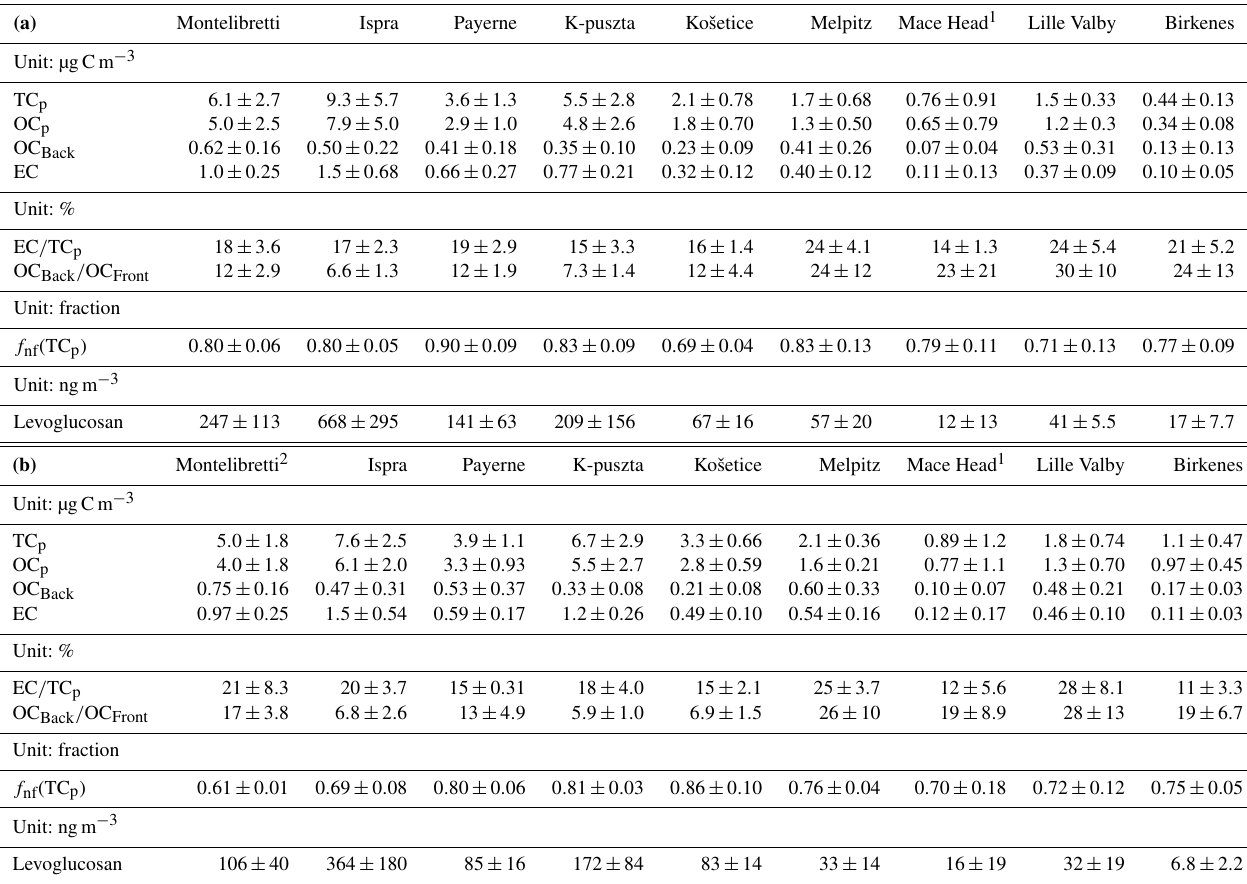
Table 2. (a) Mean ( ± SD; standard deviation) concentrations of carbonaceous sub-fractions and levoglucosan in PM 1 2009. The EC / TC p ratio, the OC Back / OC Front ratio, and non-fossil fractions of TC p ( f nf (TC p )) are also listed. The sites are ordered by latitude from south to north. (b) Mean ( ± SD; standard deviation) concentrations of carbonaceous sub-fractions and levoglucosan in PM 1 during fall 2008. The EC / TC p ratio, the OC Back / OC Front ratio, and non-fossil fractions of TC p ( f nf (TC p )) are also listed. The sites are ordered from by latitude from south to